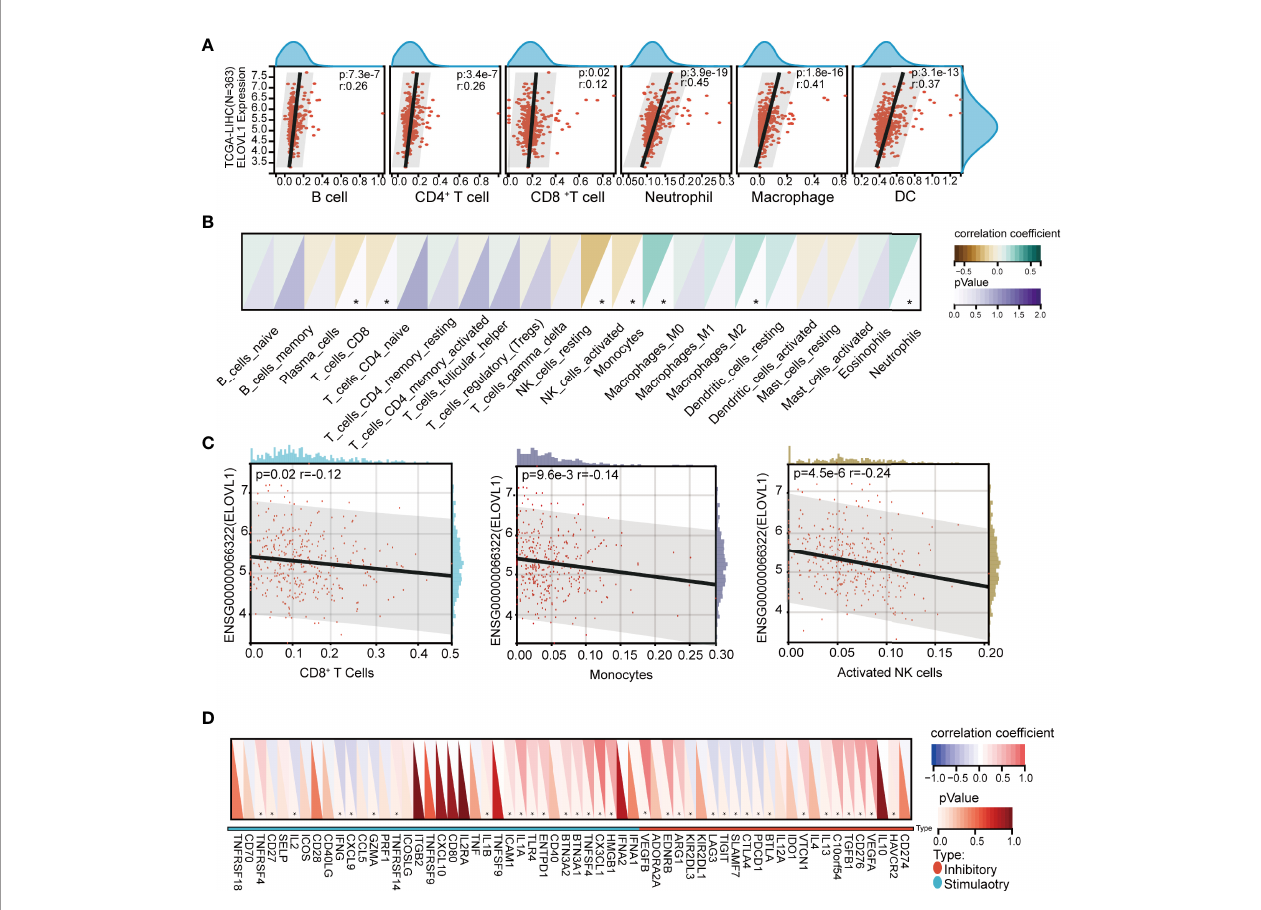
FIGURE 7 | Correlation of ELOVL1 expression with immune cell in fi ltration and immune checkpoints in HCC. (A) Correlation of ELOVL1 expression with immune cell in fi ltration in HCC (TIMER). (B, C) Correlation of ELOVL1 expression with immune cell in fi ltration in HCC (CIBERSOR). (D) Expression of ELOVL1 and immunological checkpoints. *P <